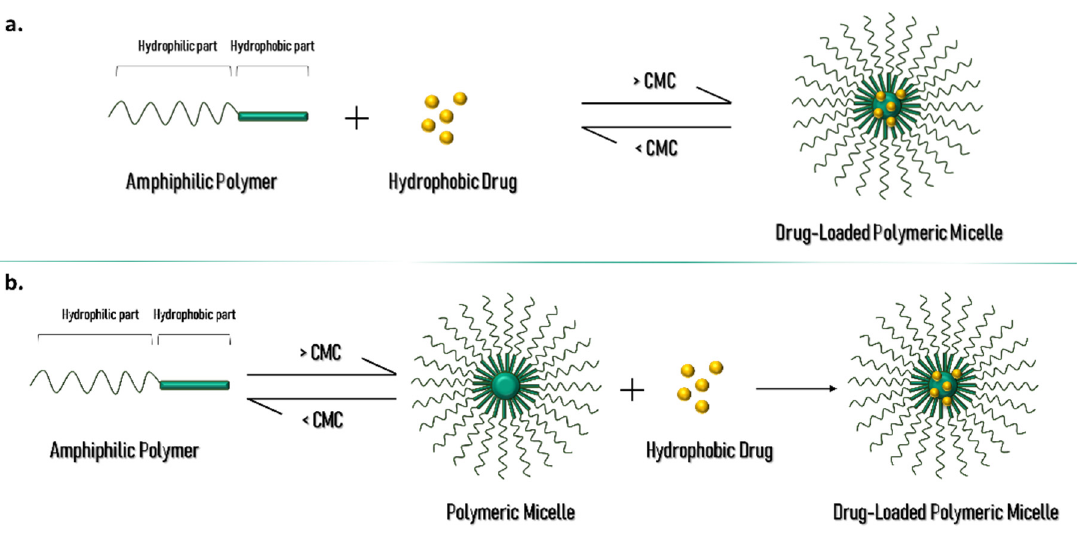
Figure 2 . Schematic representation of PM and drug-loading process in ( a ) one step and ( b ) two steps.